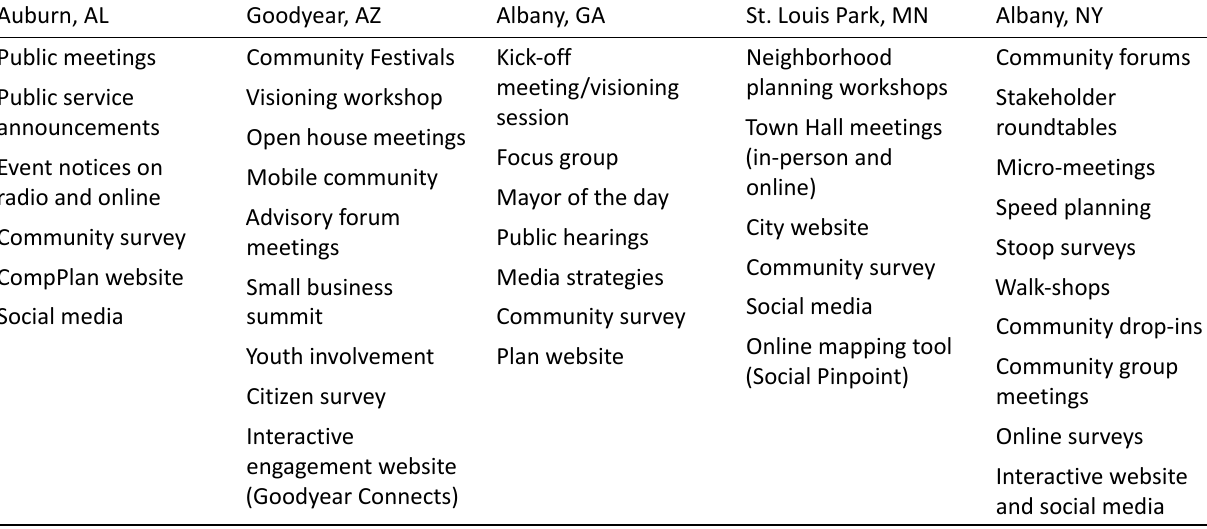
Table 3. Public outreach and participation methods applied by the study